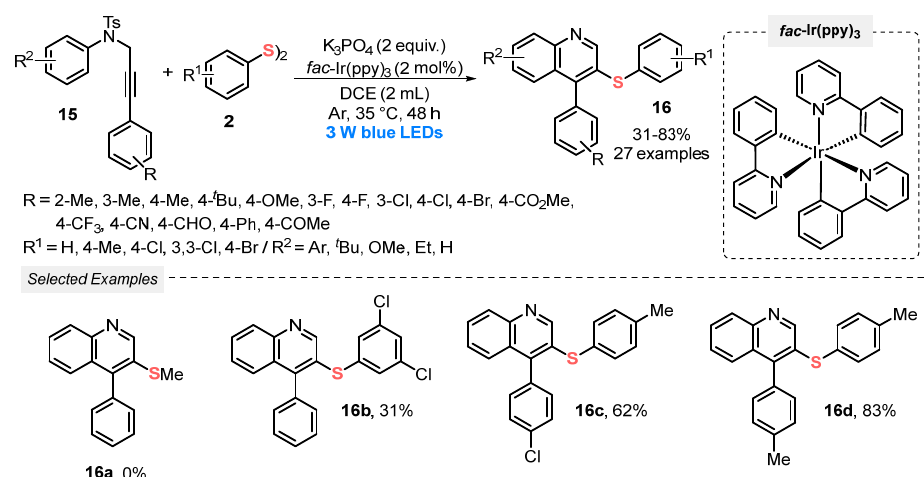
Scheme 6. Synthesis of 3 ‐ phenylthioquinoline 16 promoted by sulfenylation/cyclization of N ‐ aryl